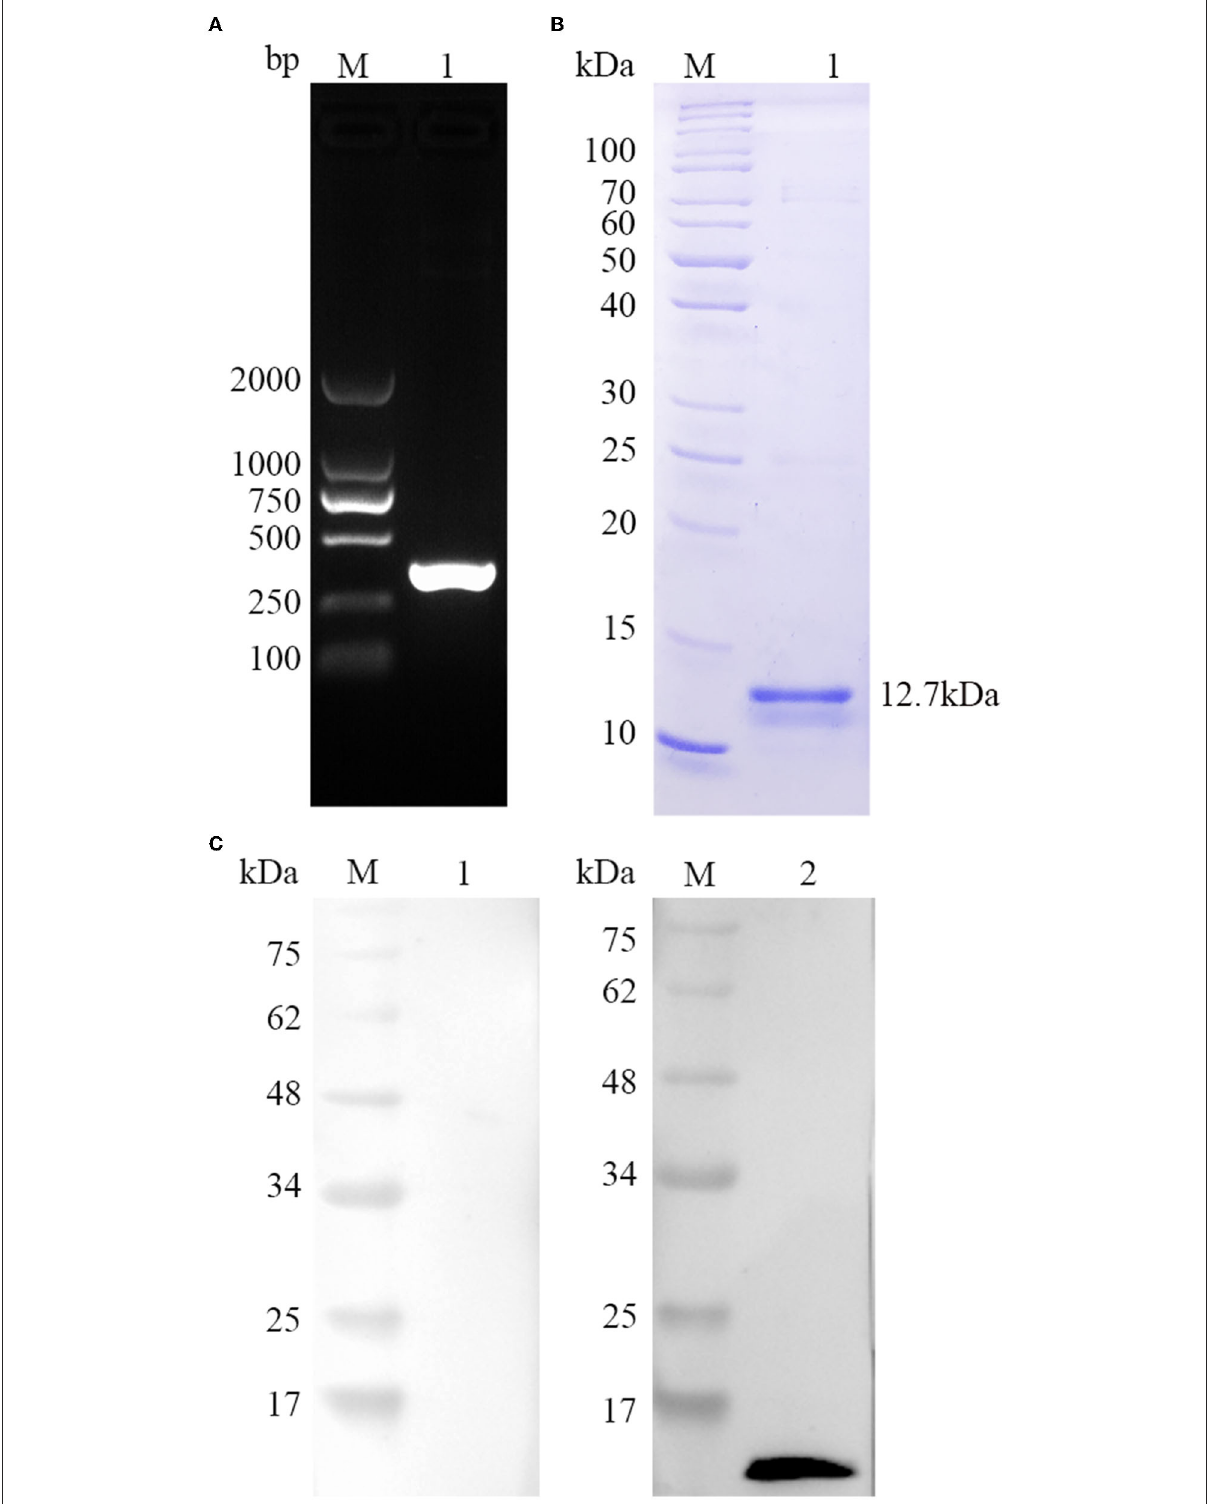
FIGURE2 Gene amplification, protein purification, and recognition of TgBFD1. (A) The amplification of TgBFD1 was determined by 1% agarose gel electrophoresis. (B) Purified rTgBFD1 was run in 12% SDS-PAGE gel and visualized using Coomassie blue G250. (C) Recognition of rTgBFD1 was performed using toxoplasmosis mice sera. M, protein molecular mass standards; Line 1, normal mice IgG served as control; Line 2, sera obtained at 6 weeks after infection from mice infected with the T. gondii PRU strain served as a primary